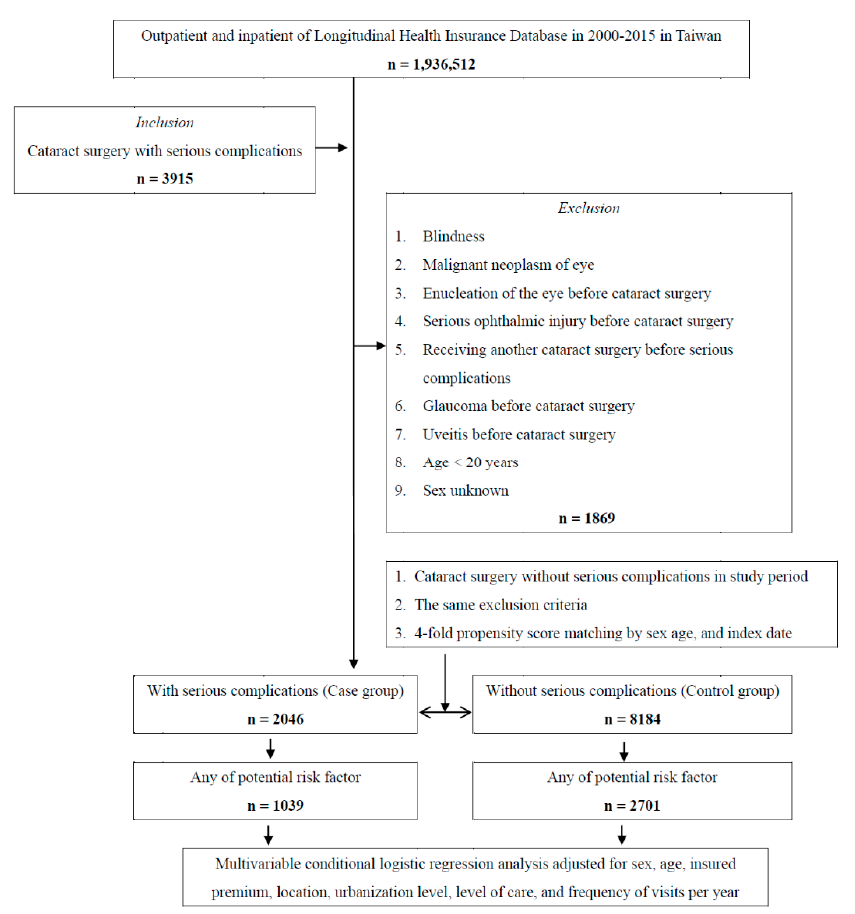
Figure 1. Flowchart of study sample selection. Table 1. Characteristics of case cohort and control